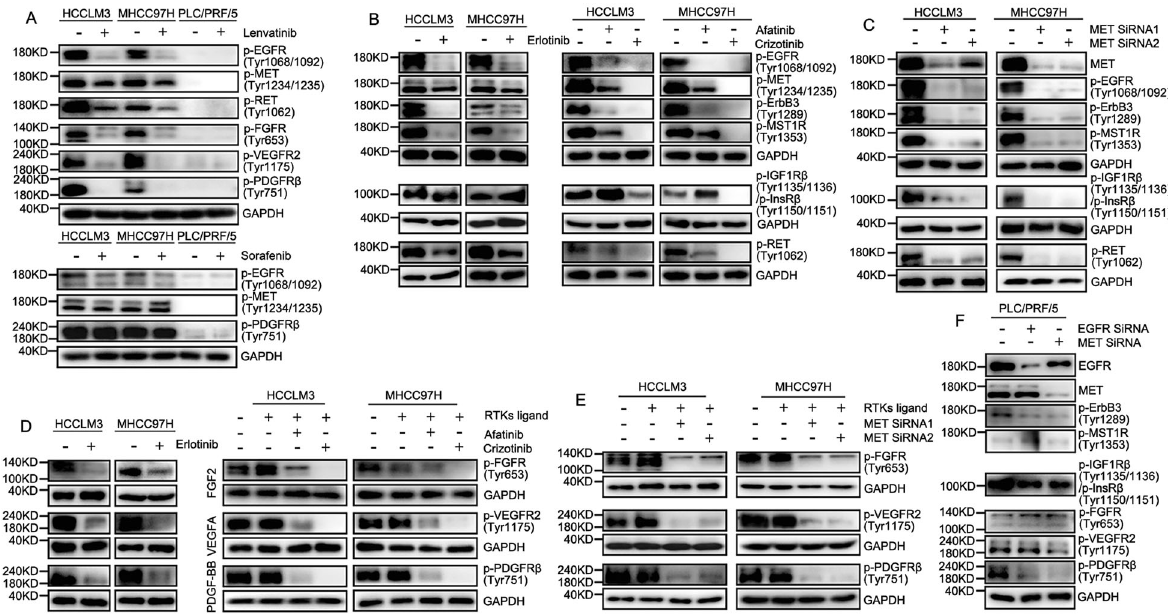
Fig. 6 EGFR/MET participated in regulation of phosphorylation of hetero-RTKs. A Western Blot was used to observe phosphorylation of RTKs in HCCLM3, MHCC97H and PLC/PRF/5 cell lines with Lenvatinib or Sorafenib added. B Western blot was used to determine the effect of down-regulation of EGFR/MET on hetero-RTKs, including: Phosphorylation of EGFR, MET, Her3, RON, IR/IGF-1R and RET in HCC cell lines with EGFR/MET inhibitor added. C Phosphorylation of EGFR, Her3, RON, IR/IGF-1R and RET in HCC cell lines with MET knock-down. D Phosphorylation of FGFR1, VEGFR2 and PDGFR β with ligand stimulated in HCC cell lines with EGFR/MET inhibitor added. E Phosphorylation of FGFR1, VEGFR2 and PDGFR β with ligand stimulated in HCC cell lines with MET knock-down. F Phosphorylation of RTKs in PLC/PRF/5 cell line with EGFR or MET